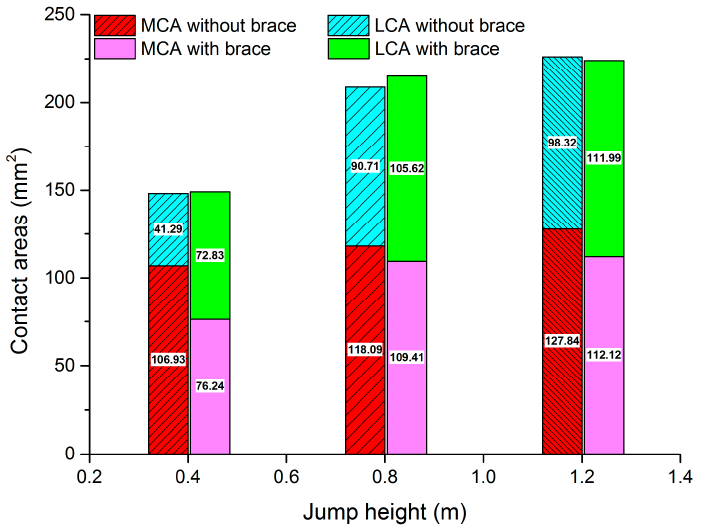
Figure 6. The medial contact area (MCA) and lateral contact area (LCA) between the menisci and articular cartilages before and after wearing the brace.